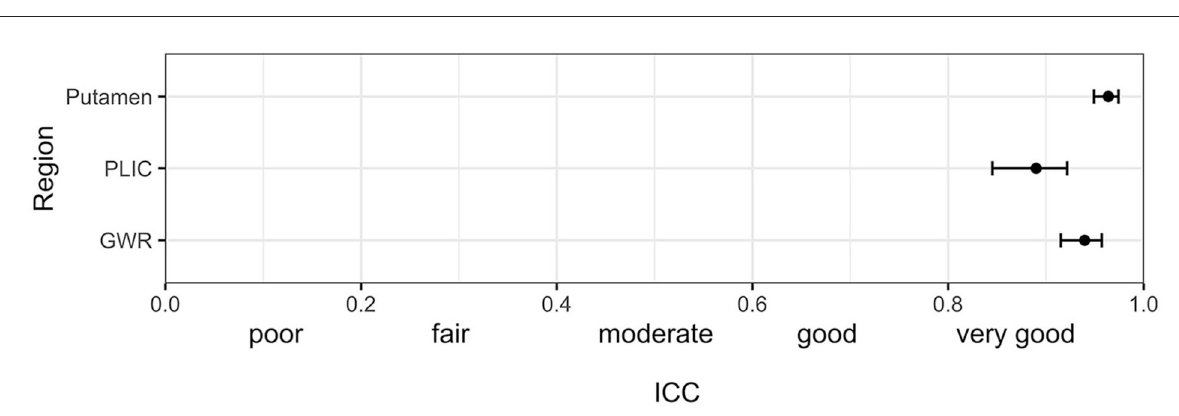
3. Inter-rater agreement was lower for ROIs placed in